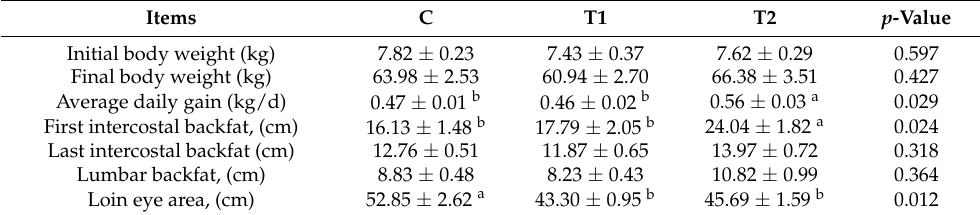
Table 3. Growth performance and carcass traits during the experiment.